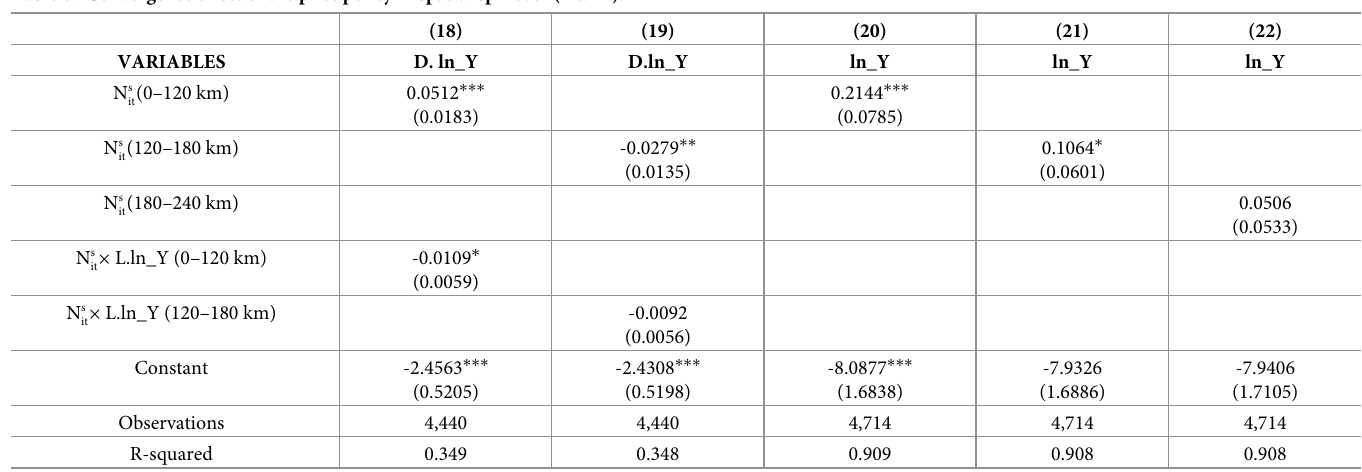
Table 6. Convergence effect of the pilot policy in spatial spillover (Plan